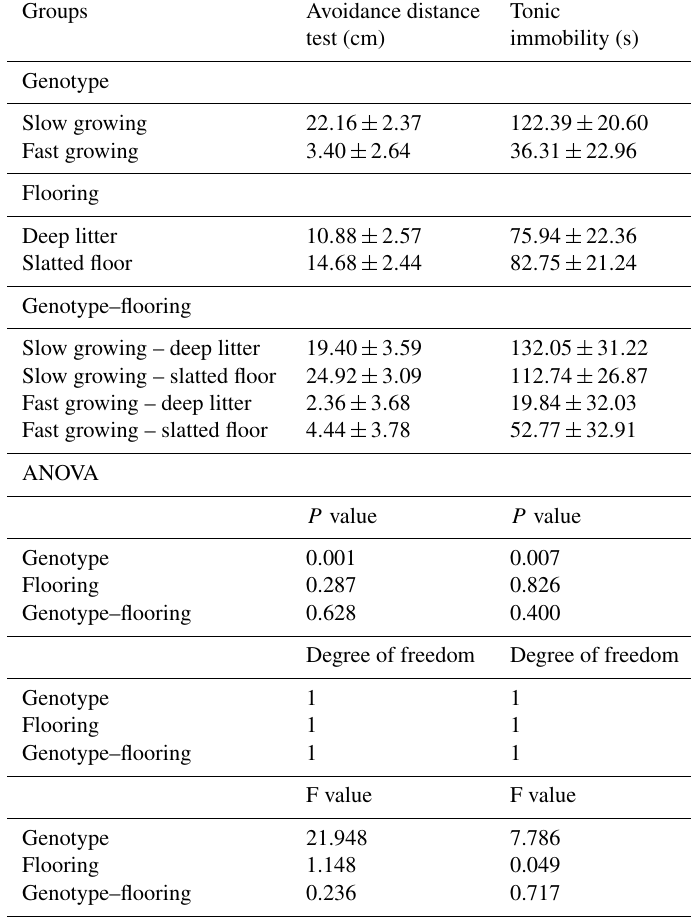
Table 5. Avoidance distance test and tonic immobility test scores in the groups (mean ± SEM, standard error of the mean).